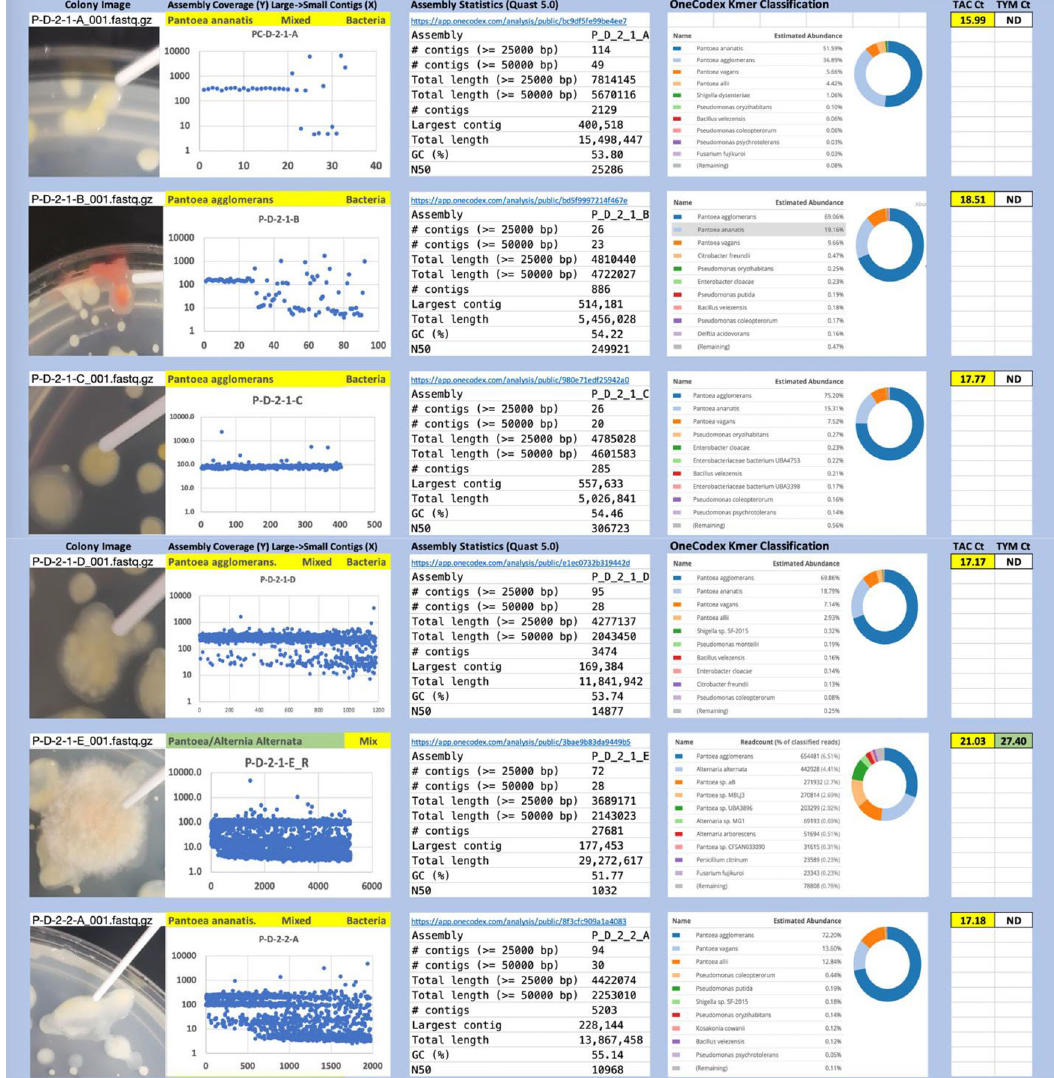
Figure 3. PDA without chloramphenicol. Colony Image (Left), Assembly sequence coverage (Y) compared with contig Length (X) where the contigs are sorted largest to smallest from left to right (Mid-Left). Assembly statistics calculated with Quast 5.0 (Mid Right). OneCodex speciated Kmer count